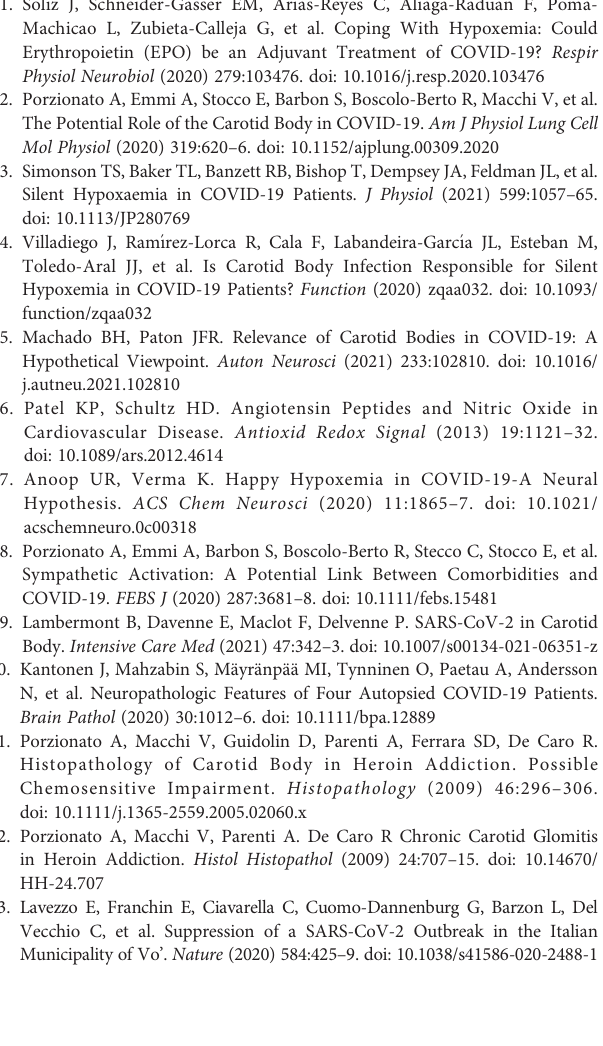
Supplementary Figure 4 | Left carotid body of Case 4 – Haematoxylin-eosin (A) andimmunohistochemitriesfornucleocapsid( B – C ;arrows:positivecells),Spike( D ; arrows: positive cells), CD68 (E) and CD3 (F) . Scale bars: 100 µm (A) ; 50 µm (B – F) . Supplementary Figure 5 | Carotid body of control old subjects – ImmunohistochemitriesforCD61 (A) ,CD68 (B) ,CD3 (C) andCD20 (D) .Scalebars: 50 µm (B –